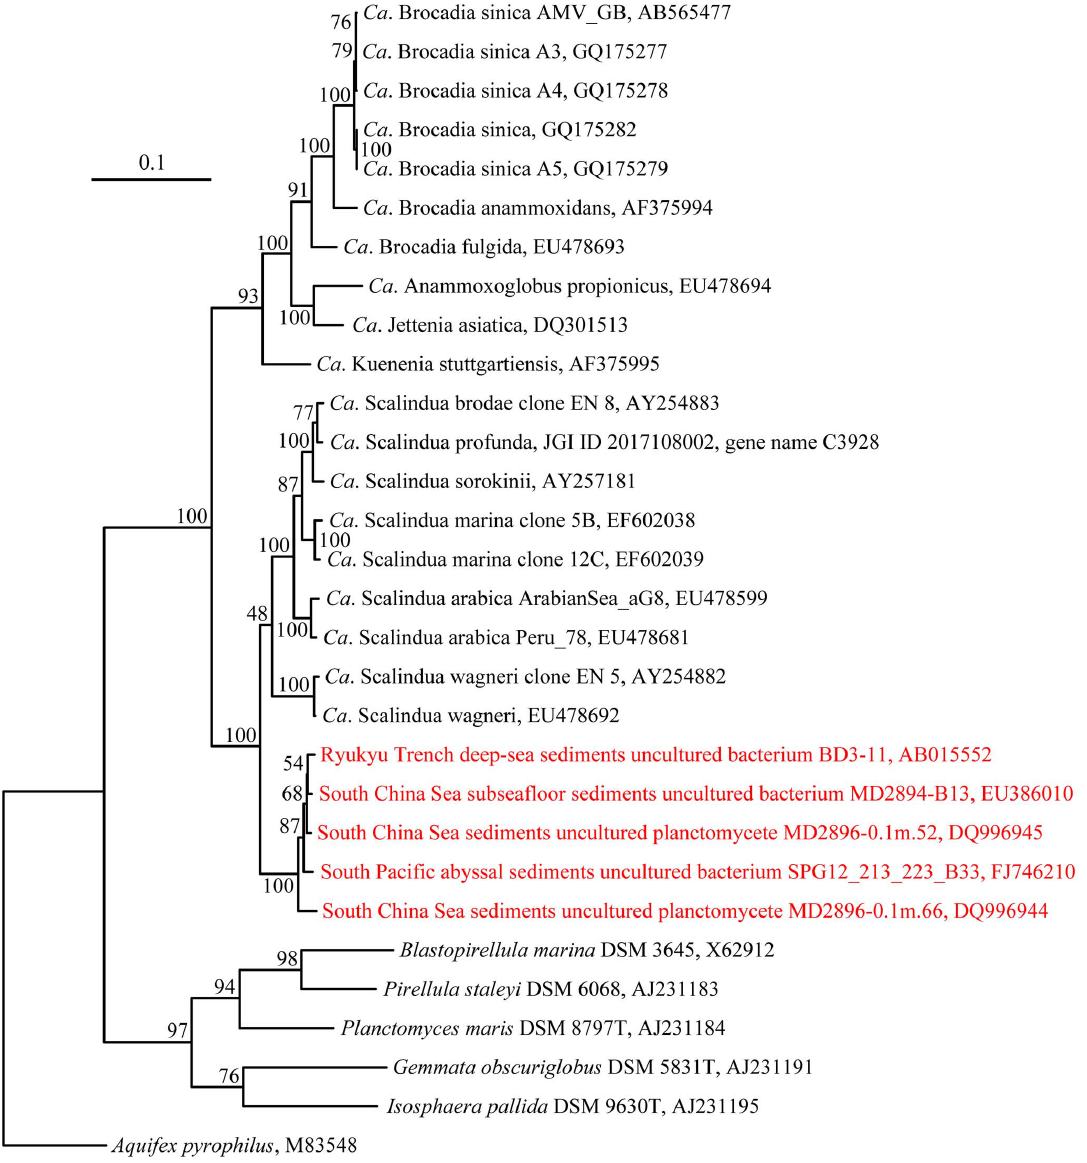
Figure 2. Phylogenetic analysis of representative Ca . Scalindua 16S rRNA gene sequences obtained from the Bohai Sea. The tree branch distances represent nucleotide substitution rate, and the scale bar represents the expected number of changes per homologous position. The Aquifex pyrophilus 16S rRNA gene sequence was used as outgroup. Bootstrap values (100 resamplings) higher than 70% are shown with solid circle symbols and those less than 70% but greater or equal to 50% are shown with open circle symbols on the corresponding nodes. The Ca . Scalindua 16S rRNA gene sequences obtained in this study are shown in bold.